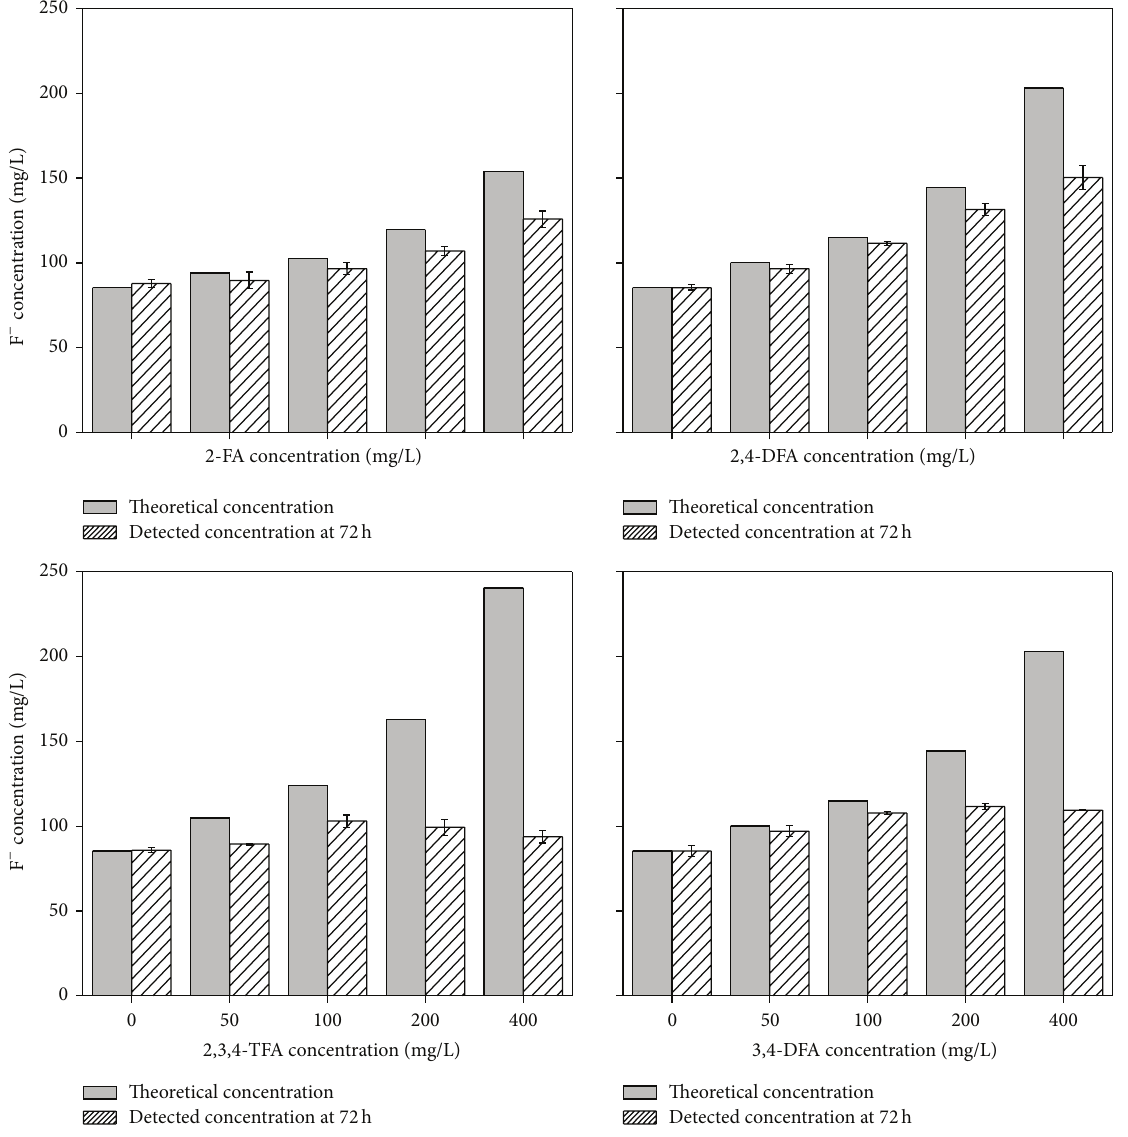
Figure 6: Fluorine ion concentration in cometabolism systems with 500 mg/L of 4-FA as the growth